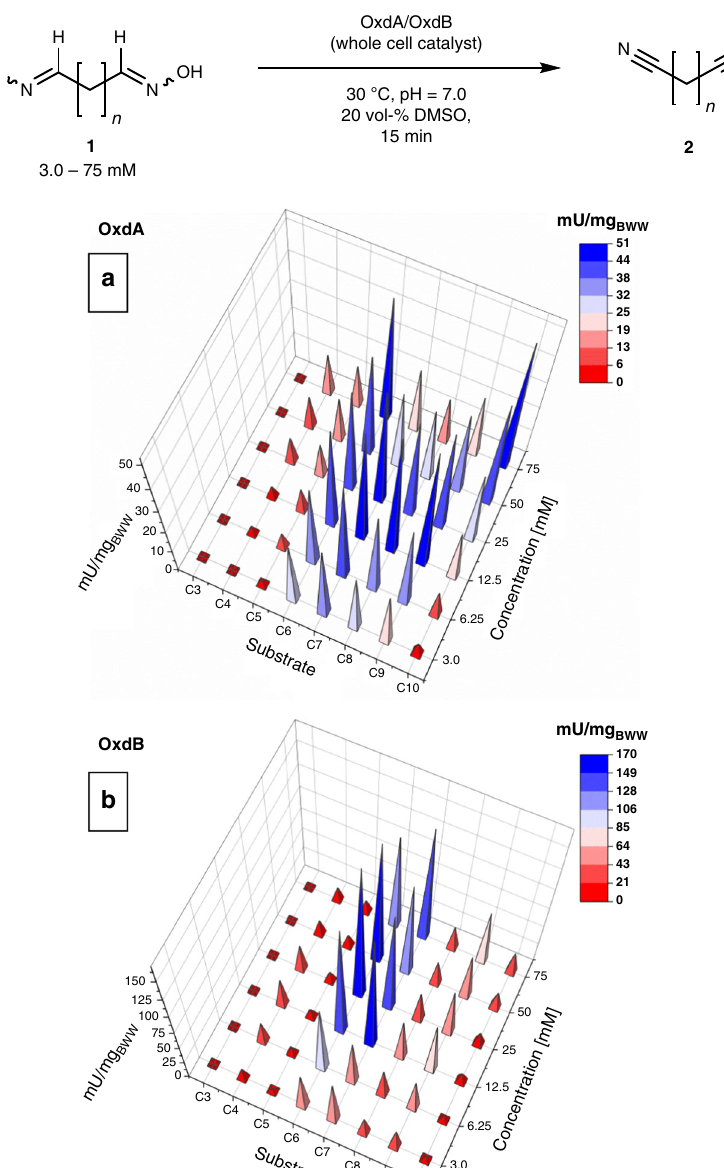
Fig. 3 Substrate scope study for the biocatalytic dinitrile synthesis. a Activity values of OxdA in mU/mg BWW for the C3-C10 dioximes. b Activity values of OxdB in mU/mg BWW for the C3-C10 dioximes. BWW Bio wet weight; U-values calculated according to the conversion of one molecule of dialdoxime to one molecule of